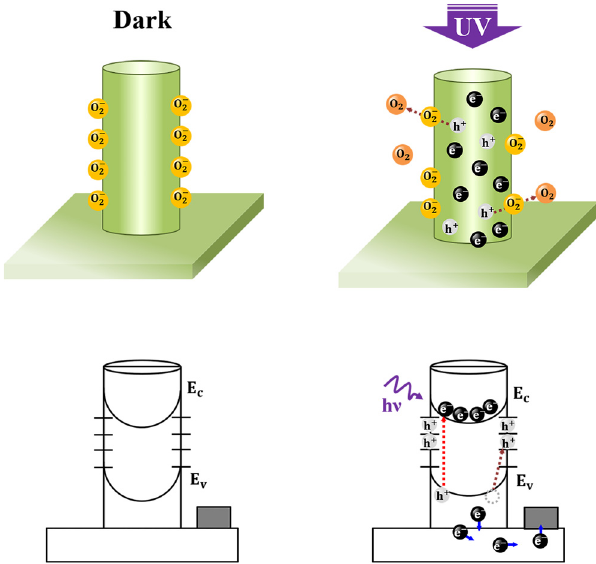
Figure5: Schematicdiagramsoftheoxygenmolecularsensitization mechanism and energy band of the β -Ga 2 O 3 nanowire in the dark and under ultraviolet (UV)